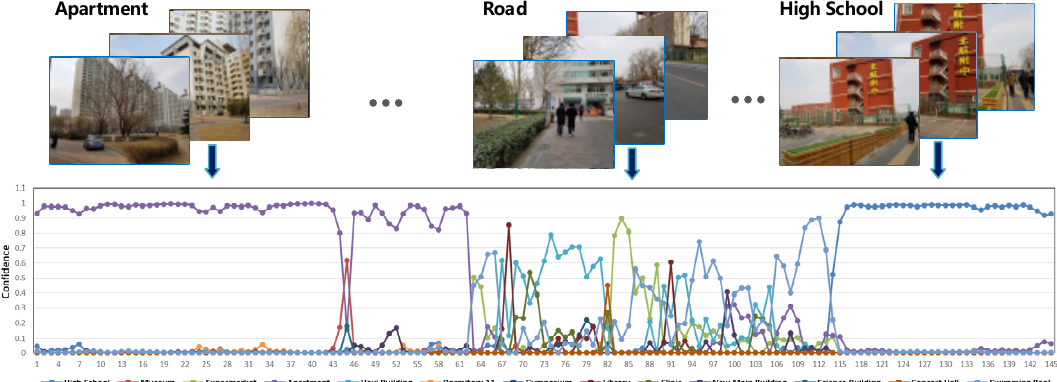
Figure 13. AlphaMEX CNN ‐ based location estimation result from Apartment to High School. Each dot in the chart represents the confidence of each frame, with different colors representing scene classes (shown in the legend). When the wearer walked in a typical scene area, the algorithm demonstrated the absolute confidence of its estimation (from first frame to 61, 116 to the end), but demonstrated random noise when the wearer walked by the road (62 to 115).